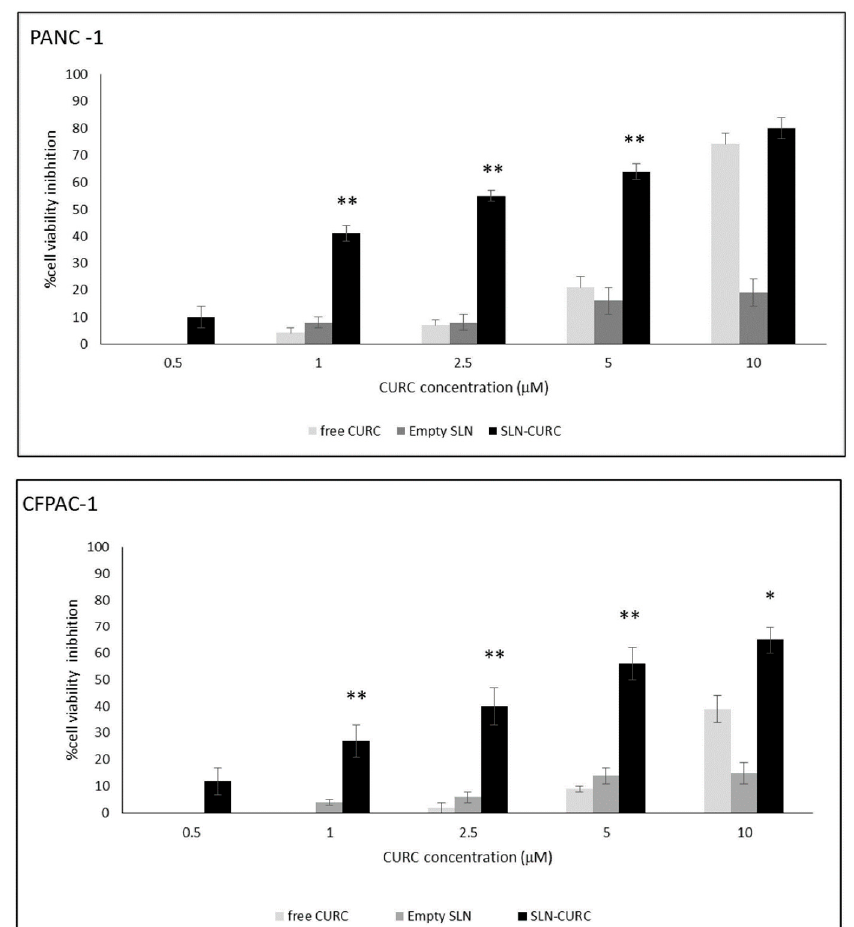
Figure 6. Inhibition of proliferation following empty SLN, SLN-CURC, and free CURC administration. PANC-1 and CFPAC-1 cells (800 cells/well) were treated with increasing concentrations of SLN-CURC and CURC for 72 h; the result was expressed as the percentage of viable cells versus the control expressed as mean ± S.E.M ( n = 5). Asterisks mean statistically significant differences of SLN-CURC vs. CURC-treated cells at the same concentrations (* p < 0.05 and ** p < 0.01).